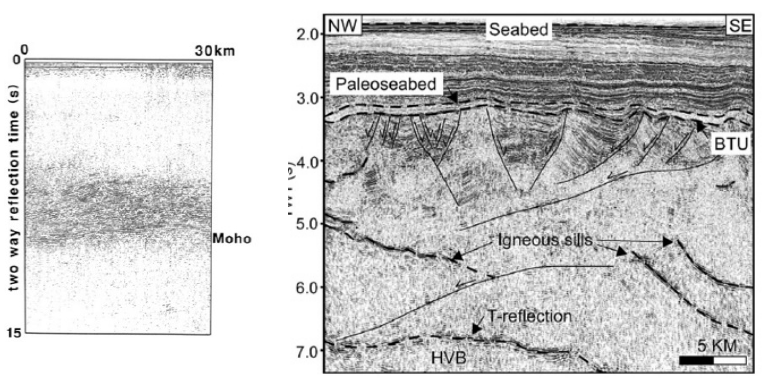
Figure 14. ( Left ) laminated reflections in the lower crust of NW Britain from the BIRPS marine reflection profiling [88]. ( Right ) distinct reflections interpreted as sills in the extended lower crust of the Norwegian continental margin [4]. T is interpreted as a reflection from the top of a high velocity body (HVB; mafic underplating?).